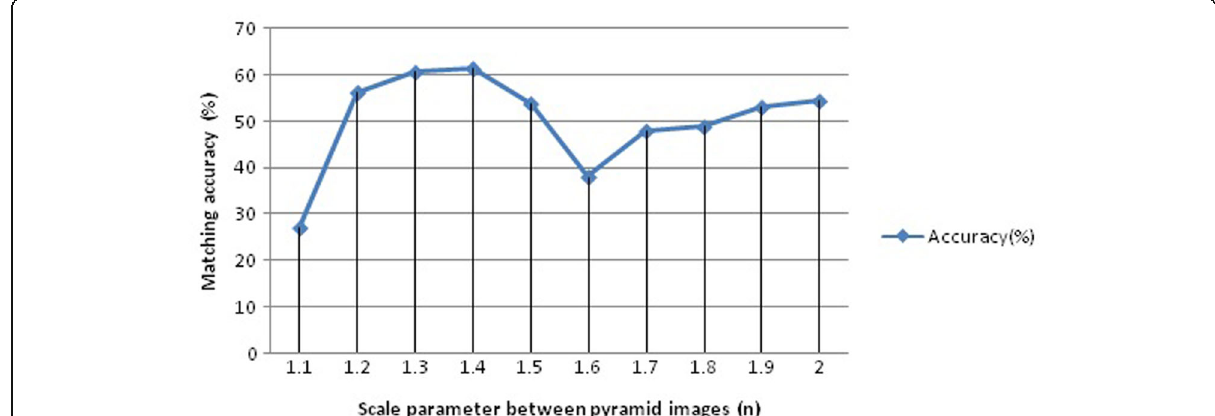
Fig. 27 Relationship between scale parameter variation and matching accuracy rate of pyramid image